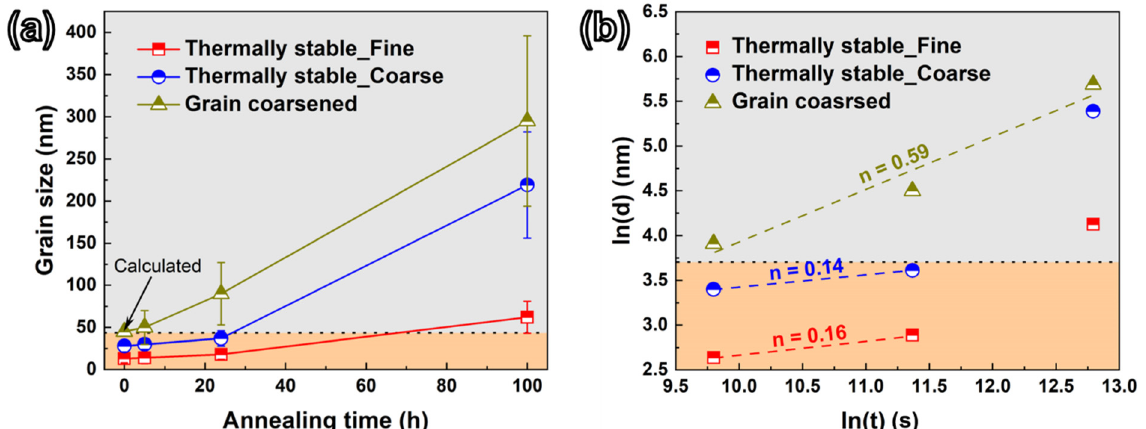
Figure 5. ( a ) Grain size evolution of FNG and CNG layers in the thermally stable area and the grain coarsened area of IN718 specimens with increasing annealing time. ( b ) The corresponding plot of ln ( d ) vs. ln ( t ) at several regions, where d and t are grain size and annealing time, respectively.